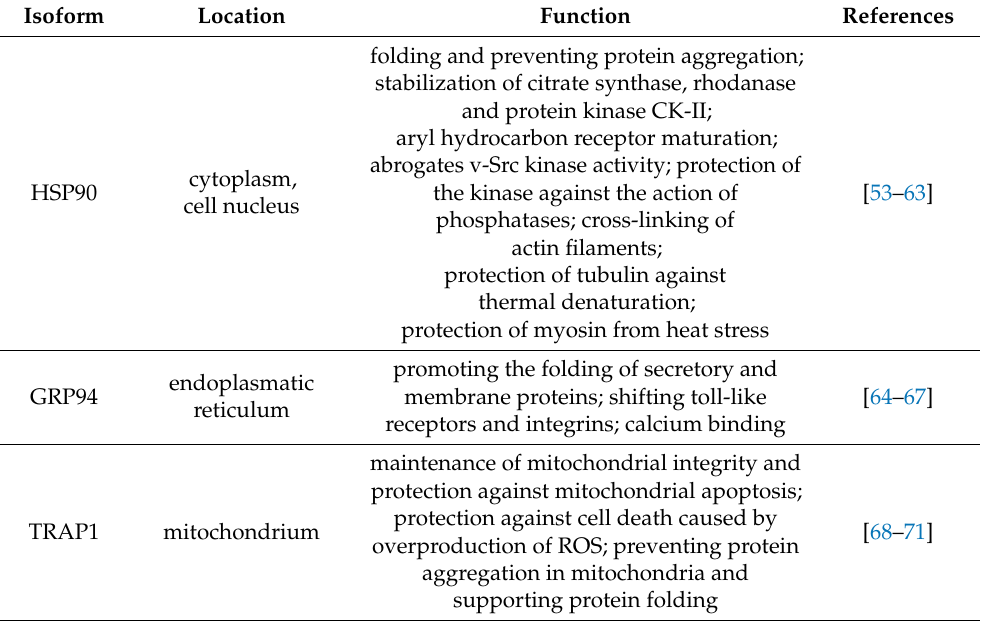
Table 2. HSP90 isoform functions.